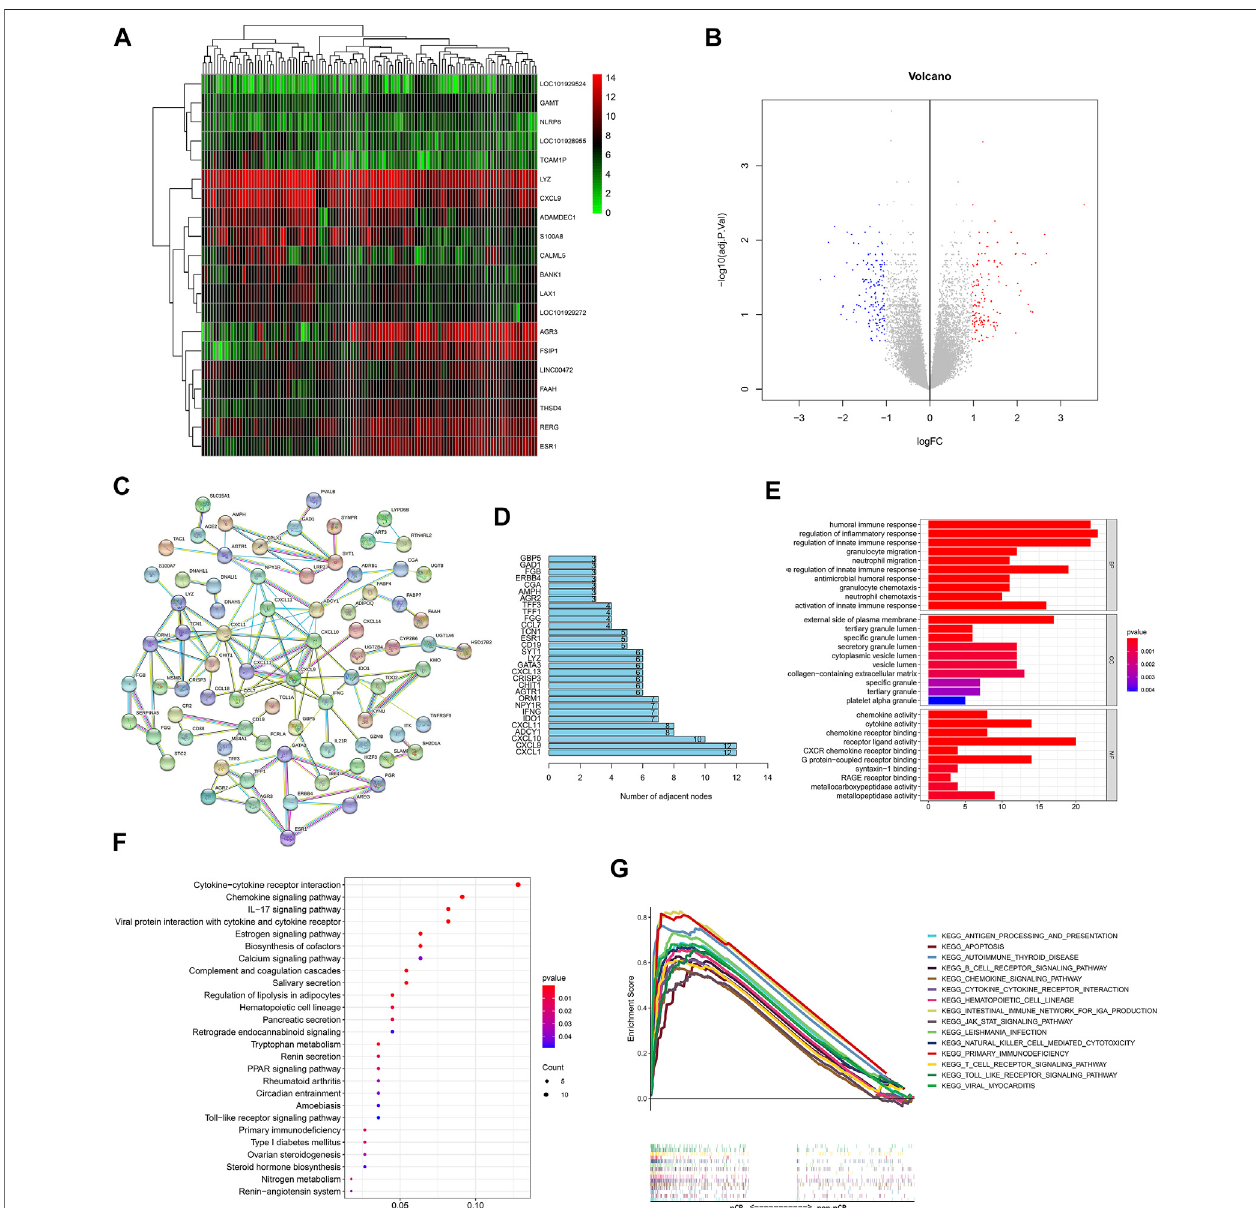
FIGURE 1 | Response of BC patients to NAC is related to immune-related genes and pathways. (A) Genetic clustering analysis of the heatmap showed DEGs ( p value < 0.05,logFC > 1orlogFC < − 1)withthefoldchangeTOP20 fromdatasetGSE32646. Theredderpoints intheheatmapindicatethehigherexpression ofthegene inthecorrespondingsample,whilethegreenpointsindicatethelowerexpression. (B) VolcanicdiagramofgeneexpressionfromthedatasetGSE32646.Allgenesarein thediagram,thereddotsrepresentlogFC > 1and p value < 0.05DEGs;thebluedotsrepresentlogFC < − 1and p value < 0.05DEGs;therestweregraypointswith no statistical signi fi cance. (C) PPI results obtained from DEGs ofdataset GSE32646. Each node represents agene and thelinebetween the circle nodes represents the interactionbetweenthetwoproteins. (D) Numberofadjacentnodesforeachgeneisshowninabarchartandgeneswithnumberofadjacentnodes ≥ 7wereidenti fi edas network core genes. (E) DEGs from dataset GSE32646 are enriched in the GO containing BP, CC, and MF. (F) KEGG pathways of DEGs from the dataset GSE32646. OnebubblerepresentsaKEGGterm,thesizeofthebubblerepresentsthenumberofgenesintheenrichedsignalingpathway,andthecolorrepresentssigni fi cance. (G) Visualization results of the KEGG pathways with NES value TOP15 obtained from the gene expression data in the dataset GSE123845.